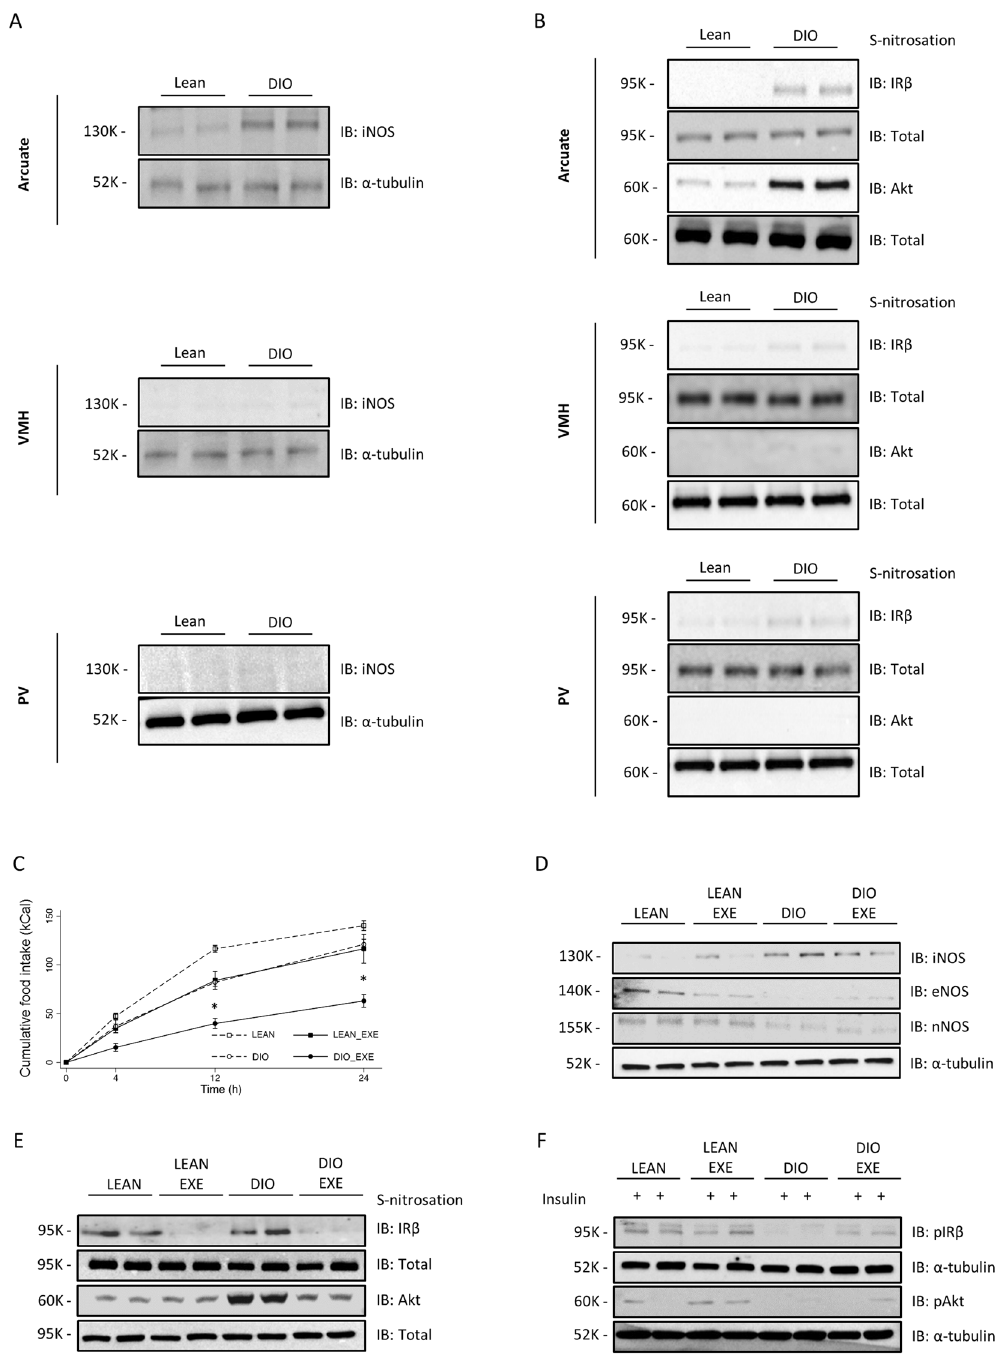
Figure 3. Exercise reverses insulin S-nitrosation in hypothalamus and normalizes energy homeostasis. Immunoblotting analysis of iNOS expression generated from lean and DIO rats in distinct hypothalamic nuclei ( A ) The biotin switch method was used to determine IR β and Akt S-nitrosation in arcuate, ventromedial (VMH) and paraventricular (PV) nuclei of lean and DIO rats ( B ) (n = 10 animals per group). Effects of exercise on food intake ( C ). Immunoblotting analysis of iNOS, eNOS and nNOS expression generated from lean and diet induced obesity (DIO) rats submitted to physical exercise ( D ). The biotin switch method was used to determine IR β and Akt S-nitrosation in hypothalamus of exercised lean and DIO rats ( E ). Western Blotting method was used to determine insulin-induced phosphorylation of IR β and Akt ( F ). Data are presented as mean ± SEM, * p < 0.05 vs. lean groups (n = 8–10 animals per